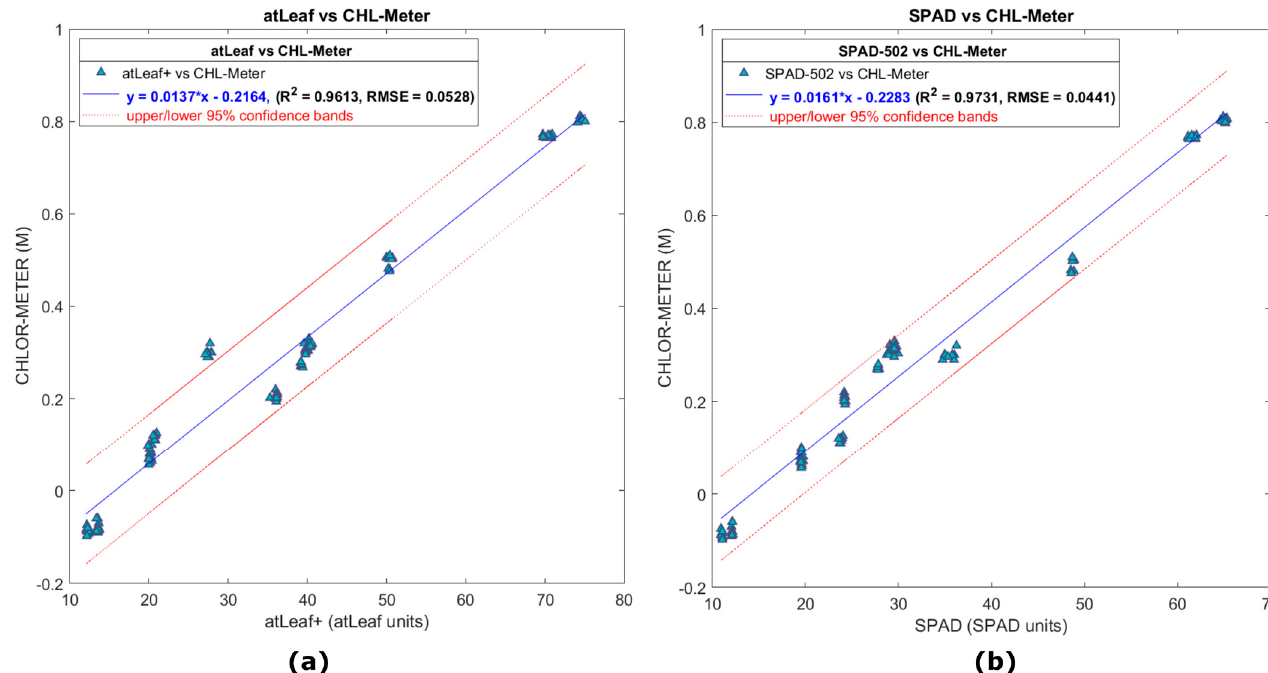
Figure 8. In ( a ), a scatter plot showing the relation of data measurements with atLeaf CHL Plus and ( b ) with SPAD-502 as compared to the proposed sensor, on all 13 green and blue color filters. Although the correlation coefficient in both cases is quite strong ( 𝑅 (cid:2870) (cid:3410) 0.96) in both linear regressions, it can be observed that the measured values with atLEaf in the case of the dark blue filter, no. 12, fall out of the 95% confidence bands. Since we are aiming in this section to evaluate by low-cost means the accuracy and repeatability of the three sen- sors, we decided to further discard all the blue filters’ values and proceed with the green one subset (no. 1, 2, 3, 4, 7, 8, 9, 10, and 13) instead.